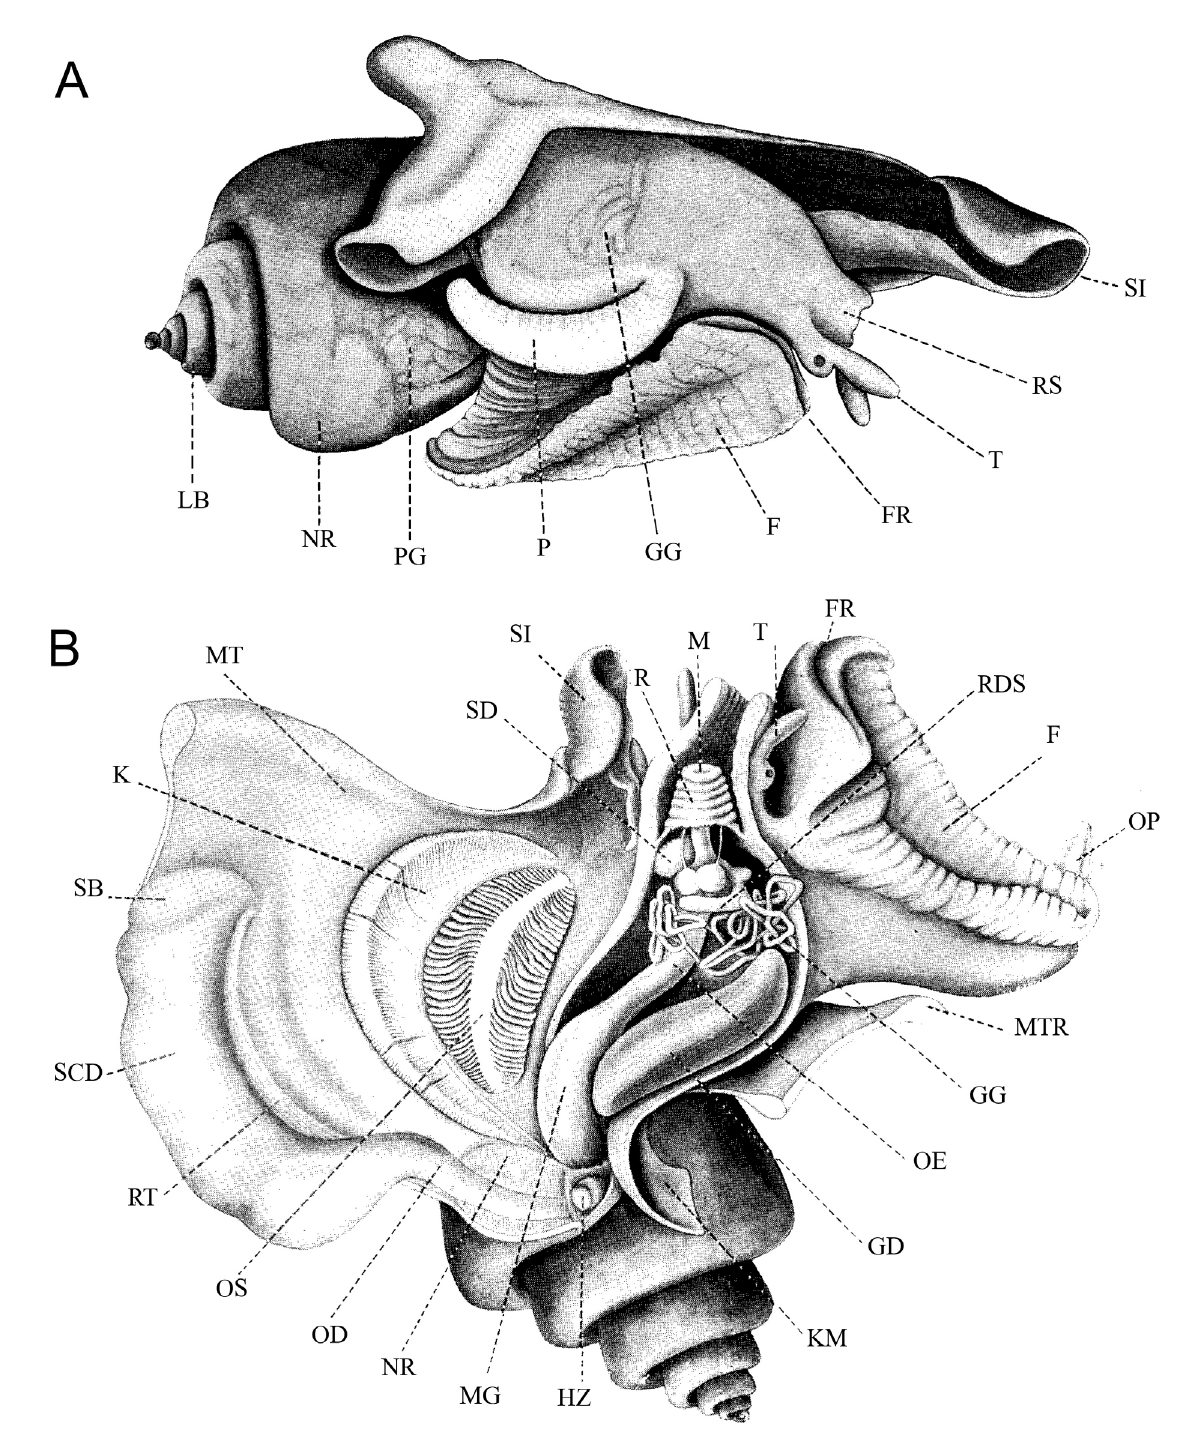
Fig. 3. Profundiconus tuberculosus (Tomlin, 1937) (reproduced from Taki 1937, with permission from the Zoological Society of Japan). A . External anatomy, male specimen. B . Internal anatomy. F = foot; FR = rostrum frontal lobe; GD = venom bulb; GG = venom duct; HZ = heart; K = gill; LB = middle gut; M = mouth; MG = stomach; MT = mantle; MTR = mantle edge; NR = kidney; OD = oviduct; OE = oesophagus; OP = operculum; OS = osphradium; P = penis; PG = prostate; R = rostrum; RDS = radular sac; RT = rectum; SB = receptaculum seminis; SCD = mucous gland; SD = salivary gland; SI = siphon; T =